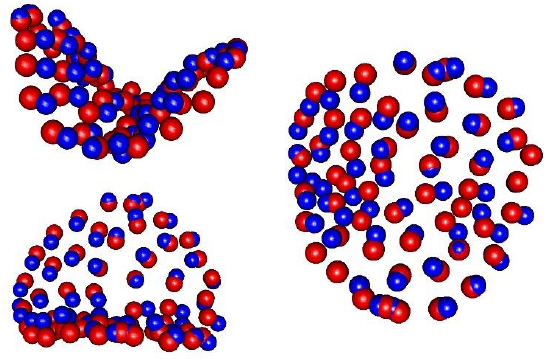
Figure 2. The image shows the differences between male and female premolar shapes after Procrustes superimposition and PLS analysis. Red landmarks indicate the baseline (female shape), and blue landmarks indicate an increase in the singular vector of PLS (male shape).